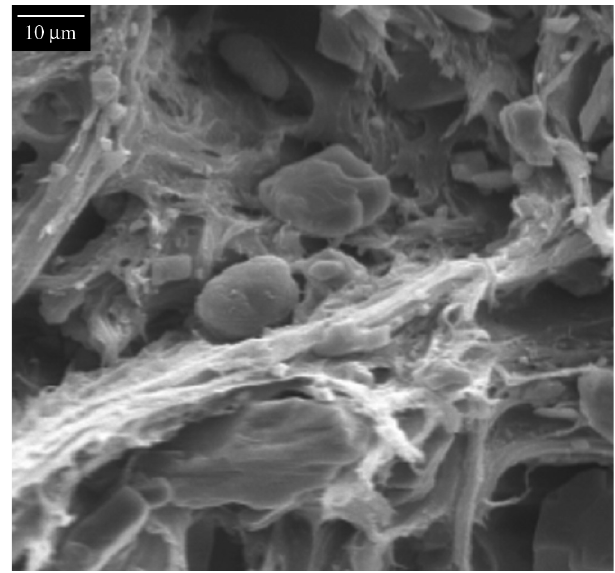
Figure 3. Characteristic aspects of the fracture surface of the silica-EVA composites. The silica particles are detached from the matrix, without signs of any EVA copolymer adhered to them. Recycled EVA sample with 5% silica, processed at 160 °C and 100